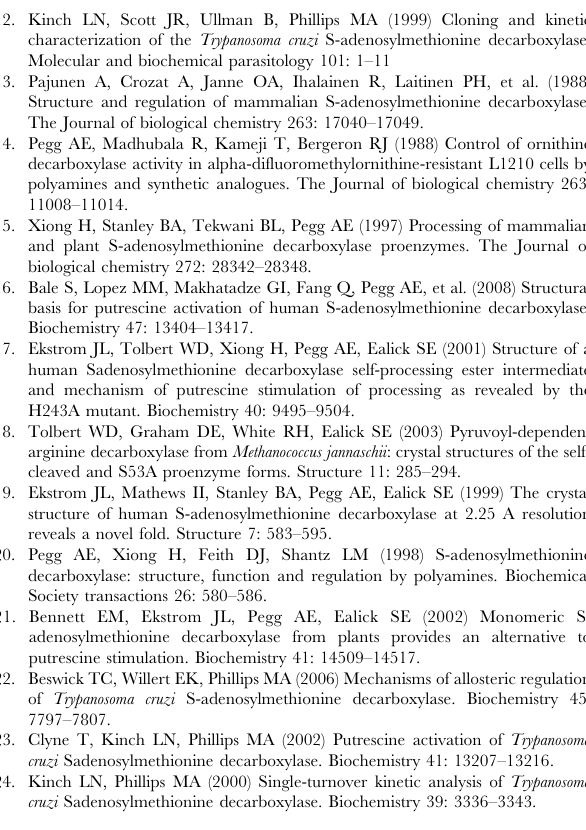
Tris-HCl pH 7.5 and 150 mM NaCL) was incubated with discarded and washed with buffer containing Tris-HCl pH 7.5and 1M NaCl, before incubating with cell lysate containing 6 6 His- ADL for 2 hours, washed with 5 column volumes of the same buffer and eluted with reduced glutathione. A similar experiment using GST alone instead of AD-GST was also performed as control. The elution products were analyzed on 12% SDS PAGE (top panel): Lane 1 marker, Lane 2 elution of GST with ADL, Lane 3: elution of AD-GST with ADL and Lane 4: AD alone. The band at , 60 kDa corresponds to full length AD-GST while the band at , 35 kDa corresponds to the autocatalyzed N-terminal fragment of AD (9 kDa) fused to 26 kDa GST (Mr 35 kDa) as well as ADL (Mr 33 kDa). To resolve this, the eluted products were then probed with anti-GST (middle panel) and anti-His (bottom panel) antibodies which show the presence of the two species. The absence of a band corresponding to ADL in Lane 2 in the anti-His blot confirms specific AD: ADL interaction.